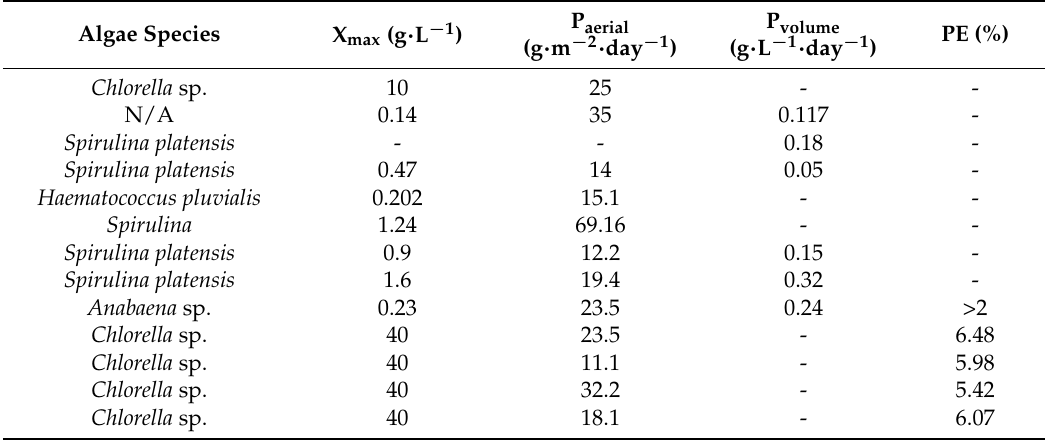
Table 4. Biomass productivity figures for open pond production system. Adapted from